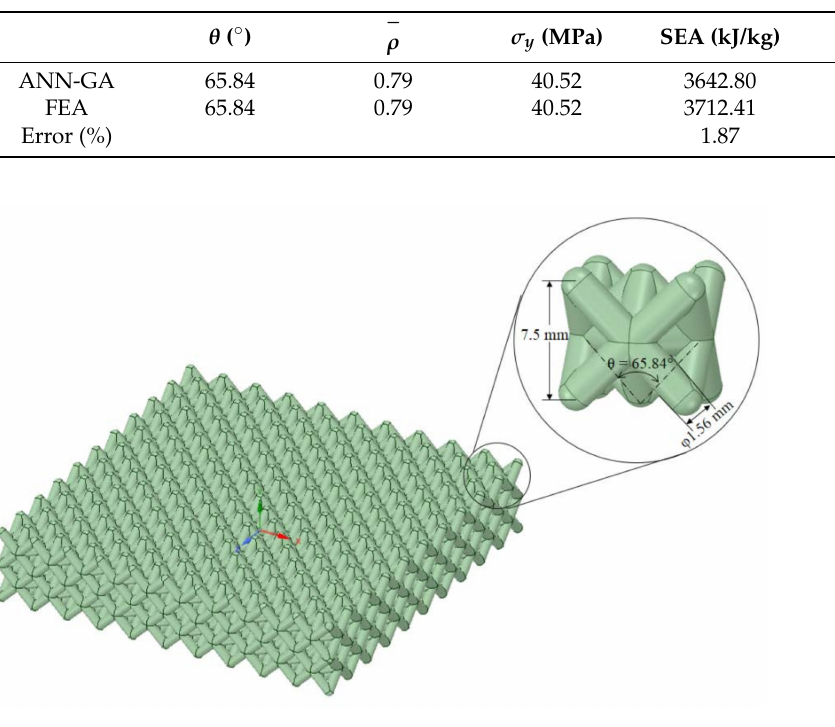
Figure 16. Geometry of optimized twisted-octet lattice structures.